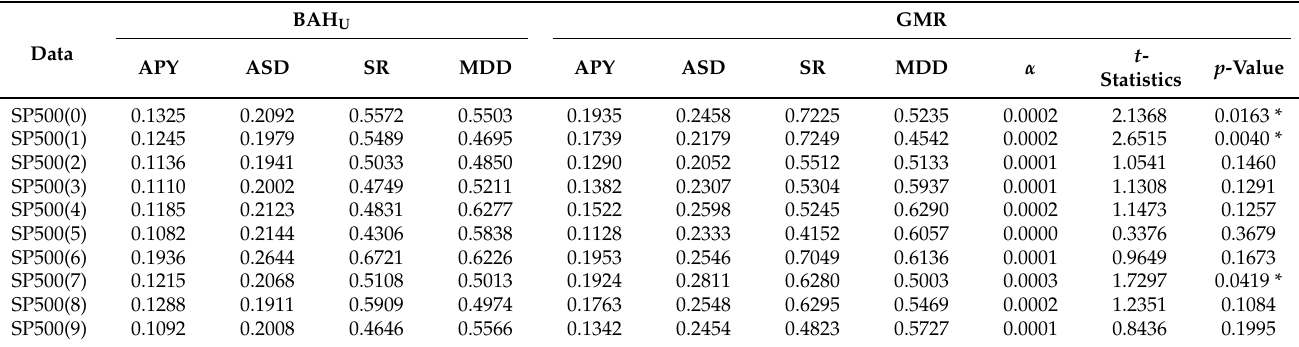
Table 7. APY, ASD, SR, MDD, and α , t -statistic, and p -value of GMR on the S&P 500 datasets.